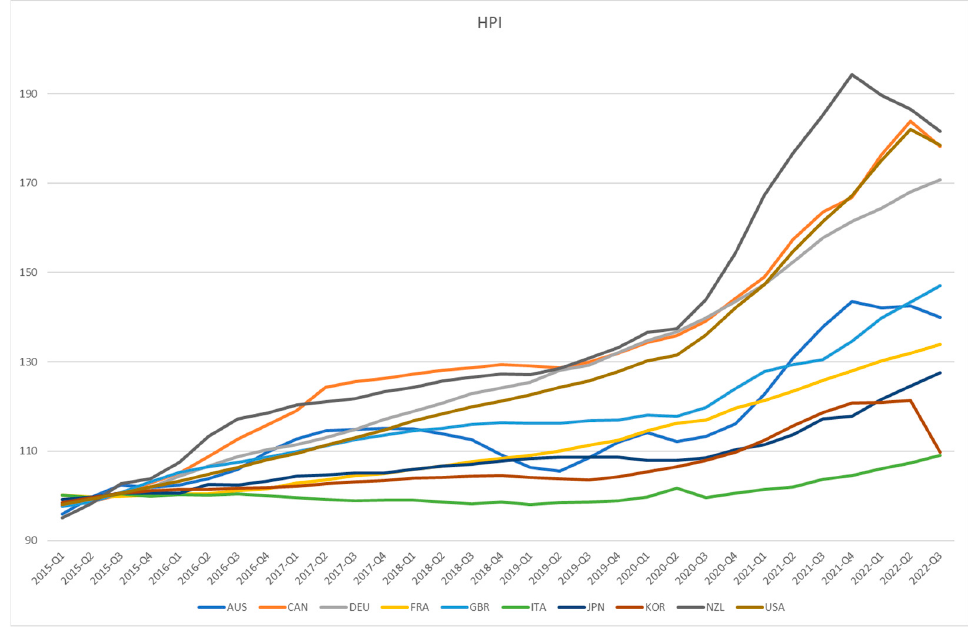
Figure 3. House price indices of ten countries from 2015 Q1 to 2022 Q3. Source: data from OECD (2022a) [36]. Legend: Australia (AUS), Canada (CAN), Germany (DEU), France (FRA), Great Britain (GBR), Italy (ITA), Japan (JAP), South Korea (KOR), New Zealand (NZL), and the United States of America (USA).